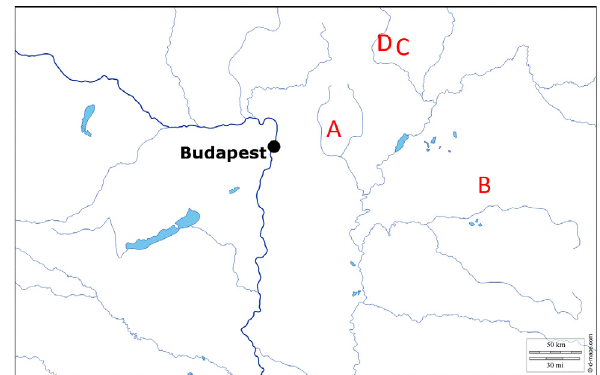
Figure 1. Collection sites in Hungary. A: Gyöngyös: Sár-hegy: Gyilkos-rét. B: Újléta. C: Rakaca: Meszes. D: Jósvaf } o: